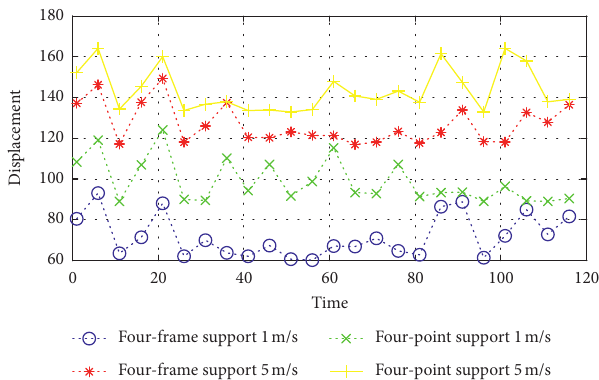
Figure 11: Time history curve of debris splash